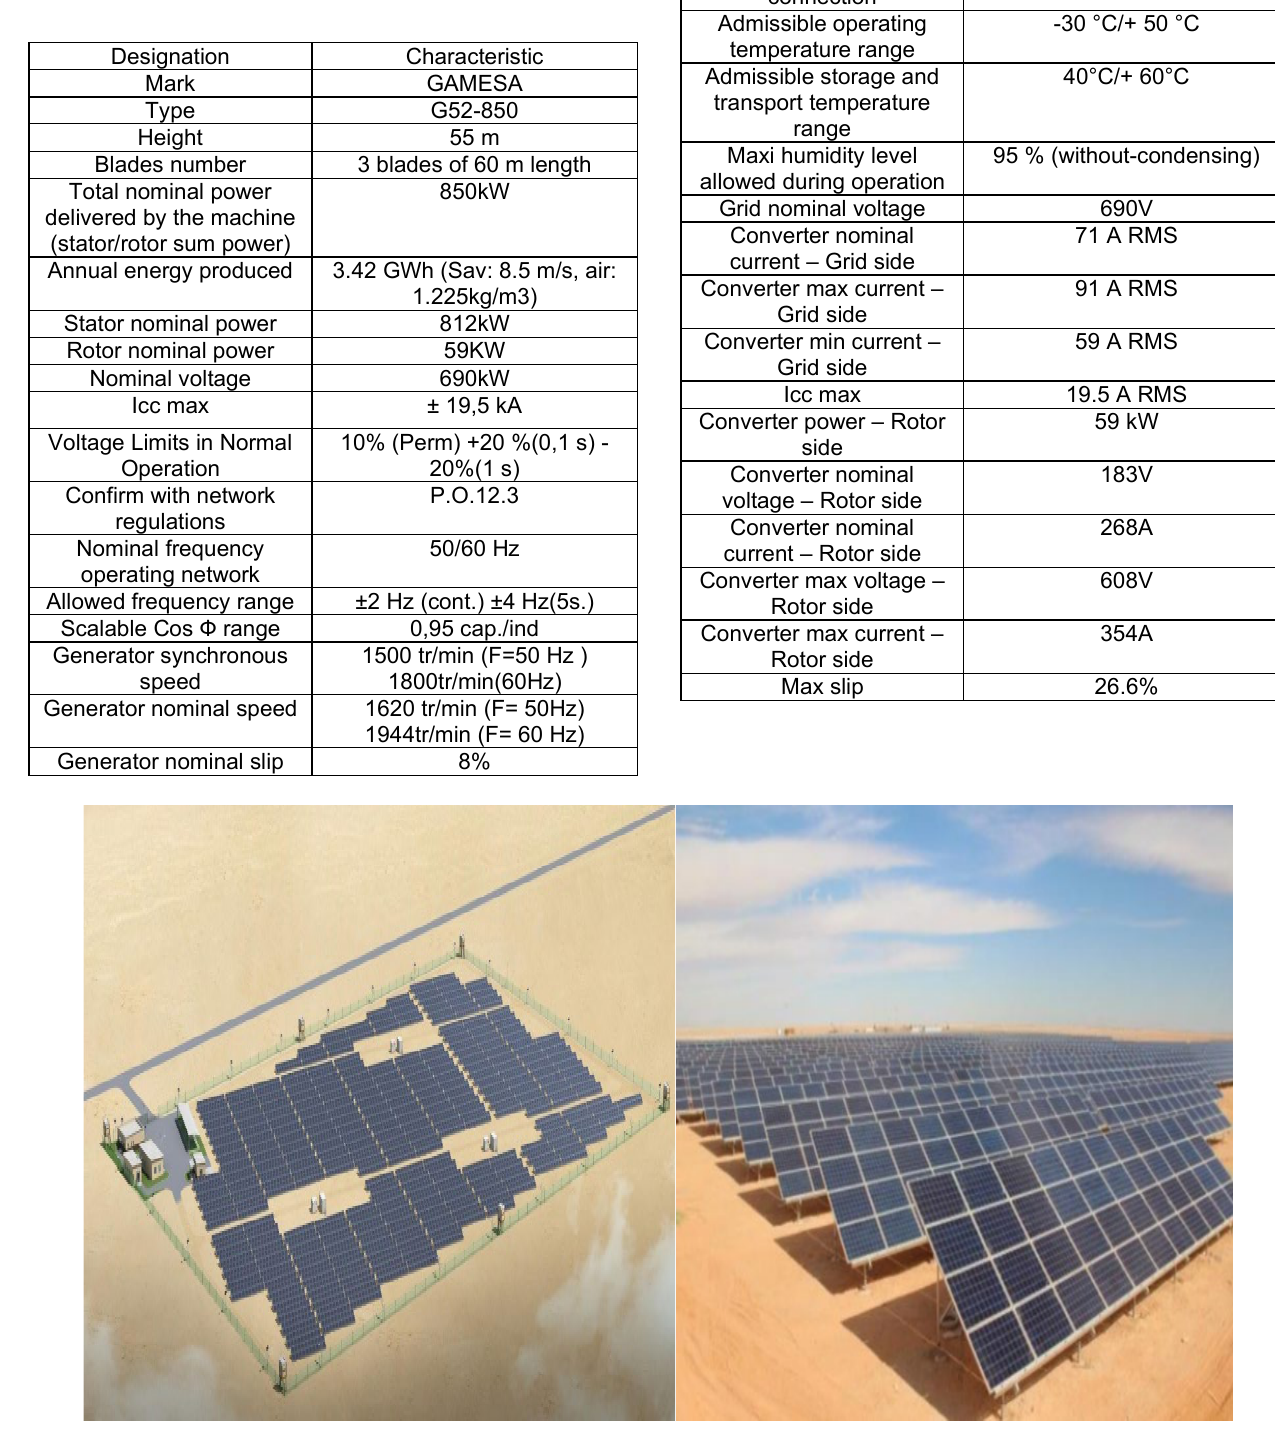
Figure 6. Panoramic photograph of the 3 MW PV power plant